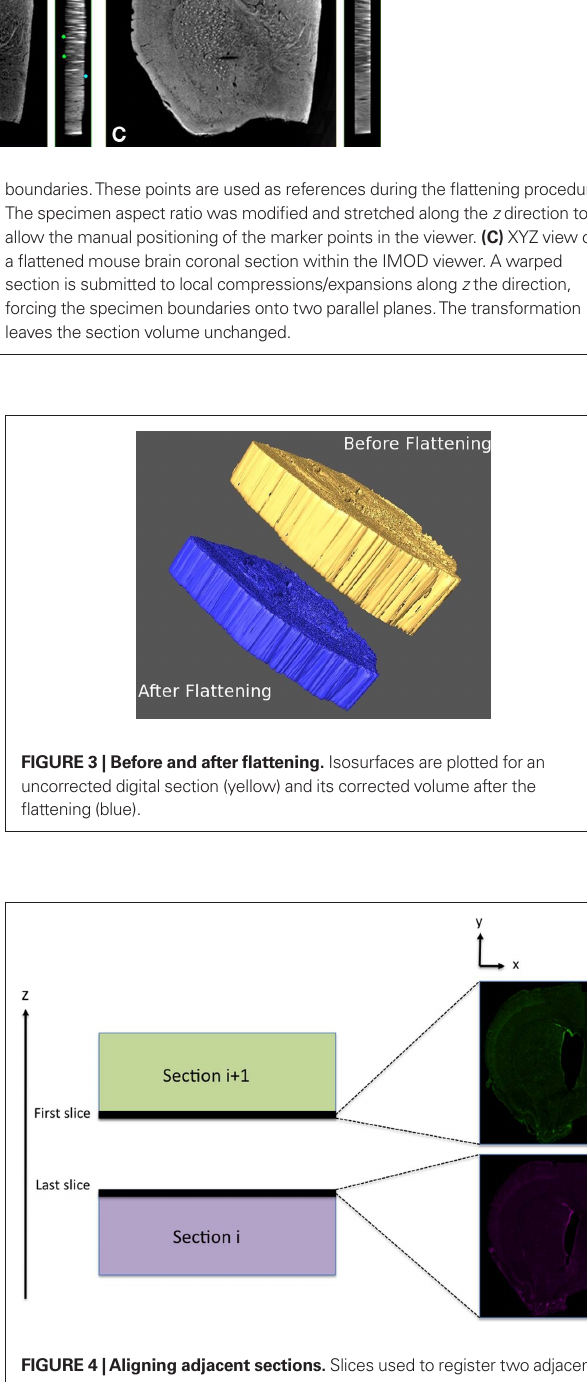
Figure 4 | Aligning adjacent sections. Slices used to register two adjacent sections during the in-plane adjustment. The first slice of a section (i + 1) should match the last slice of the previous section